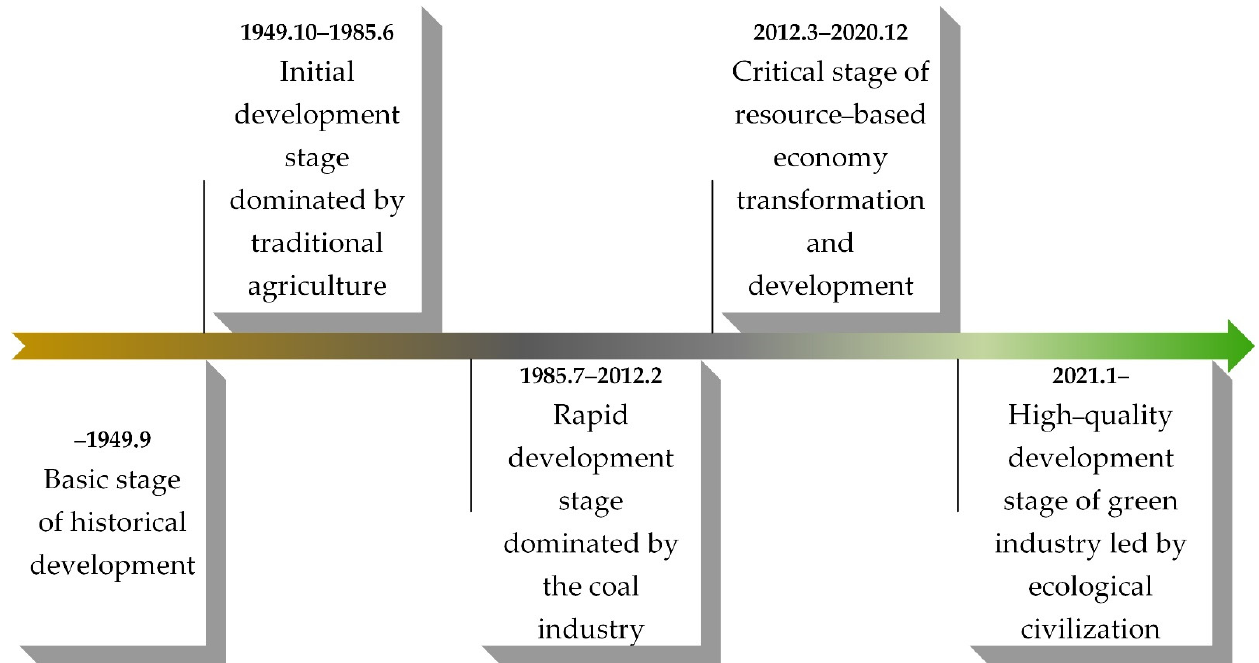
Figure 4. The development process of Pinglu. (The line with arrow represents the time sequence of Pinglu’s development; the yellow line represents the historical development foundation stage and the initial development stage relying on the traditional characteristic industries in the loess area; the black line represents the rapid development stage and part of the transformation critical stage mainly relying on coal; and the green line represents part of the transformation critical stage and the high-quality development stage seeking the transformation of resource-based towns and the green development road. The data were compiled from the policy documents published by the Peo- ple’s Government of Shanxi Province (http://www.shanxi.gov.cn/ accessed on 18 December 2021), and the figure was made by Shufei Wang.)